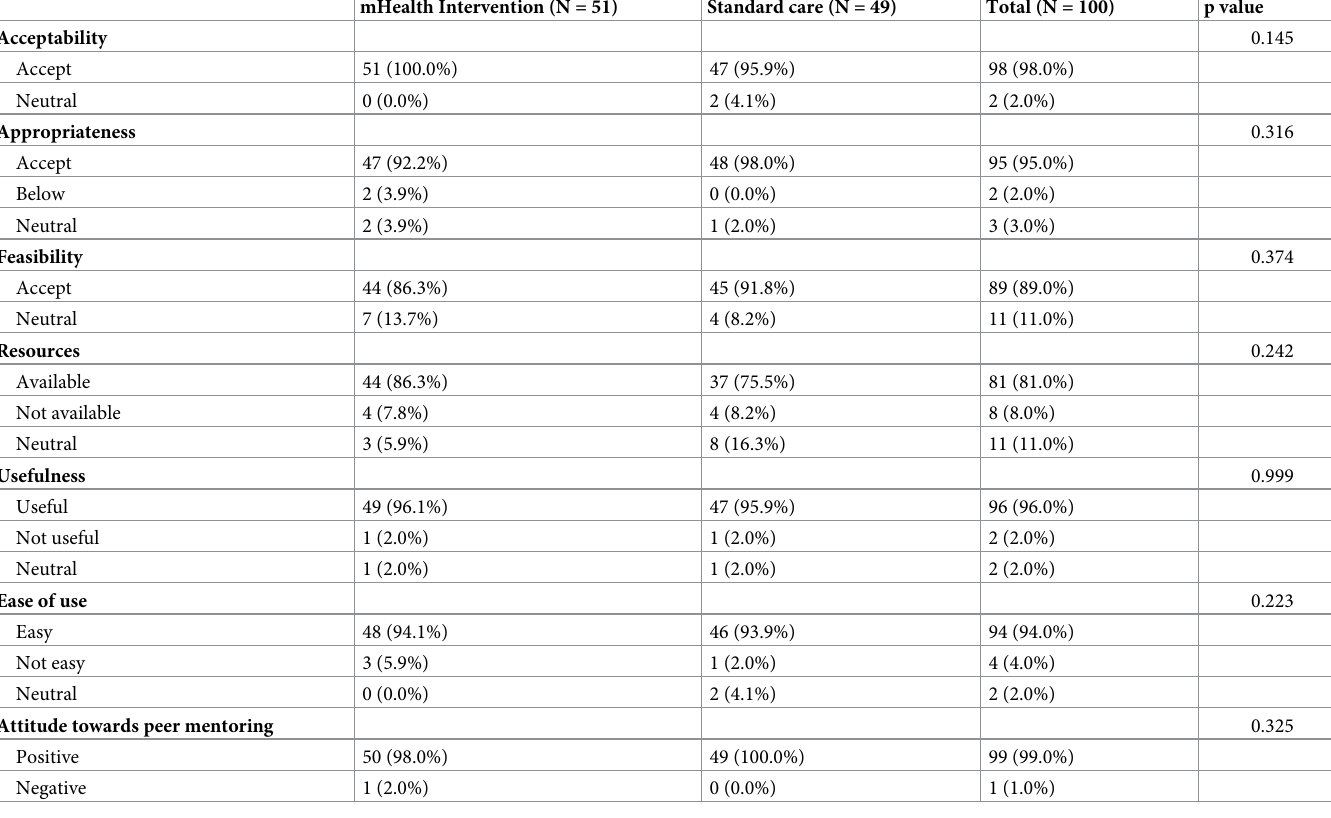
Table 3. Acceptability, APPROPRIATENESS, FEASIBILITY of Intervention Measure (AIM, IAM, FIM